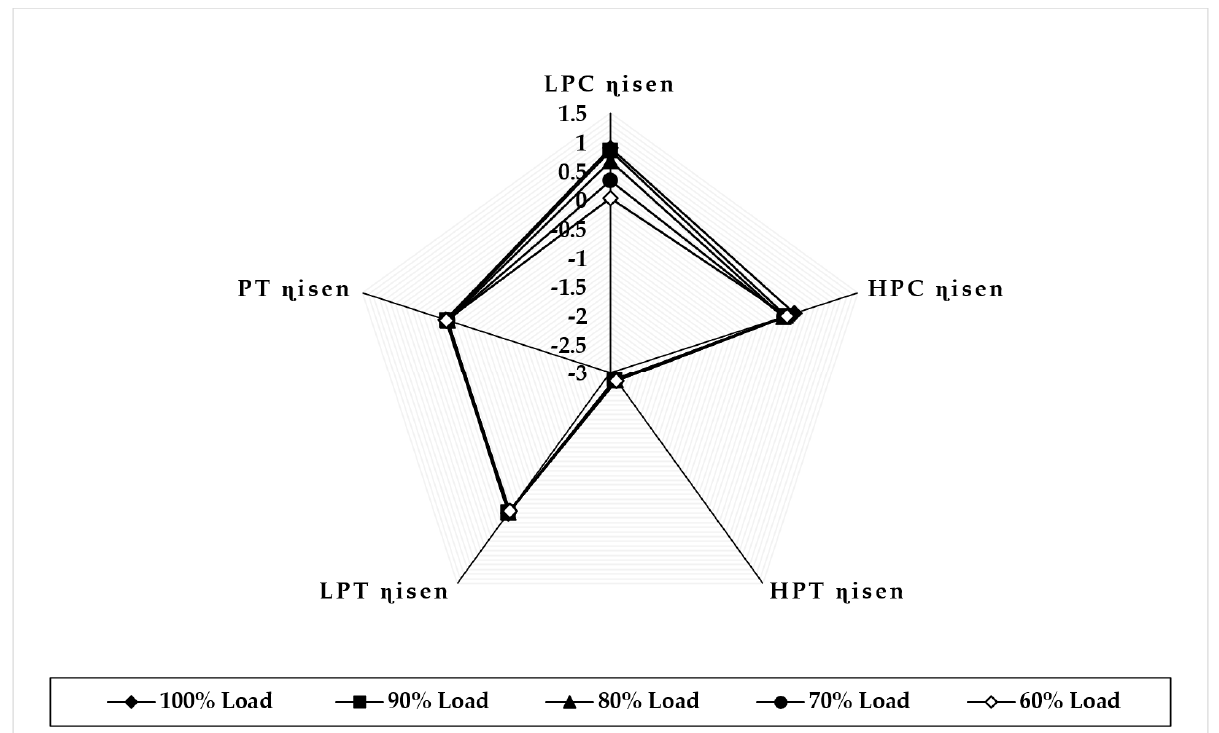
Figure 11. Deviation in component isentropic efficiency due to HPT fouling at 100% fault severity at full − load and part − load operation.